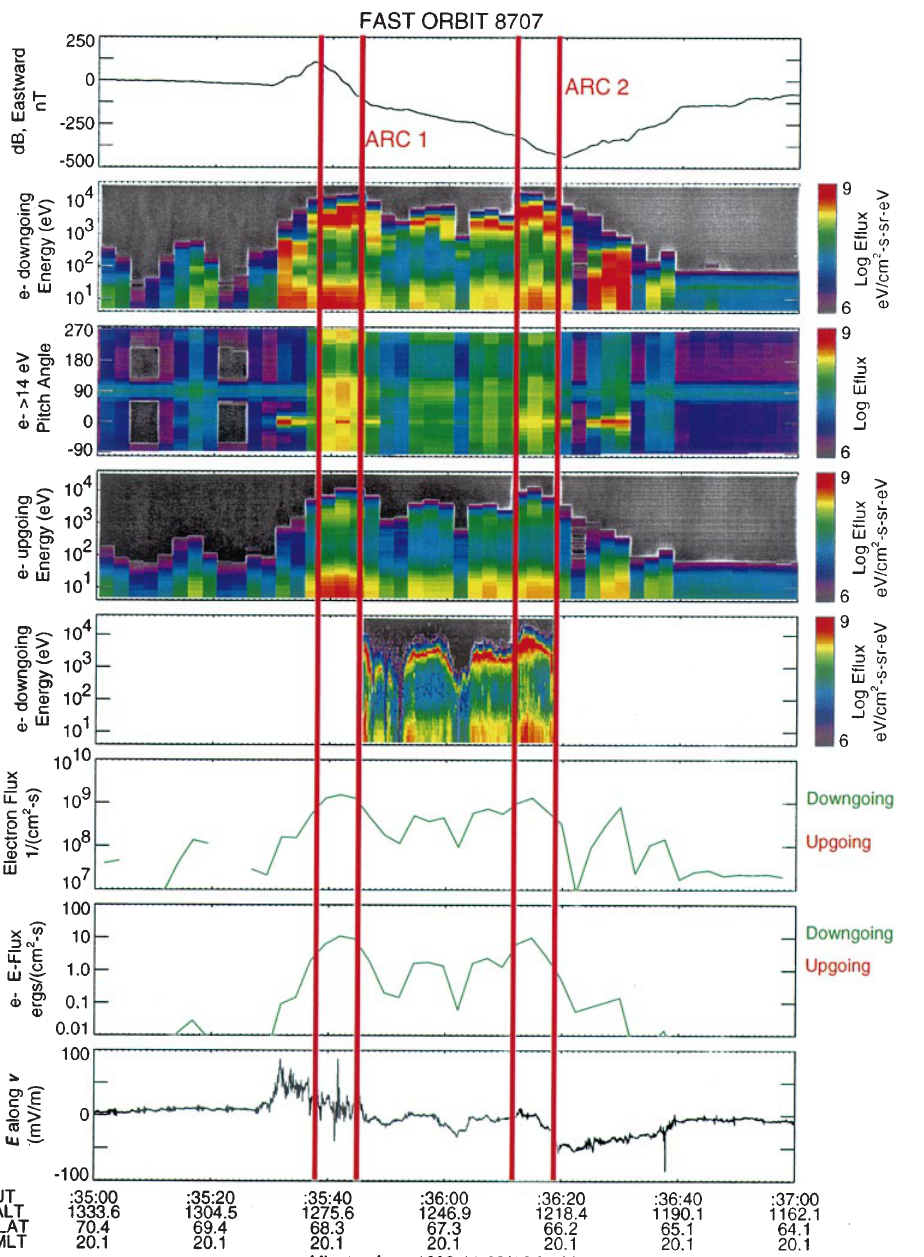
Fig. 2. FAST data for 19981103, 17:35–17:37 UT. Panels from top to bottom are numbered from 1 to 8 . 1 , Eastward magnetic field deflection from the satellite mag- netometer; 2 , downgoing electron energy flux; 3 , pitch angle distri- bution of electrons, 4 , upgoing electron energy flux, 5 , burst mode data similar to panel 2; 6 , total electron flux; 7 , total elec- tron energy flux; 8 , electric field component along spacecraft or- bit. Arcs identified from FAST electrons are marked with red lines . In panels 6 and 7 , no red curves are visible because the electron flux is downgoing throughout